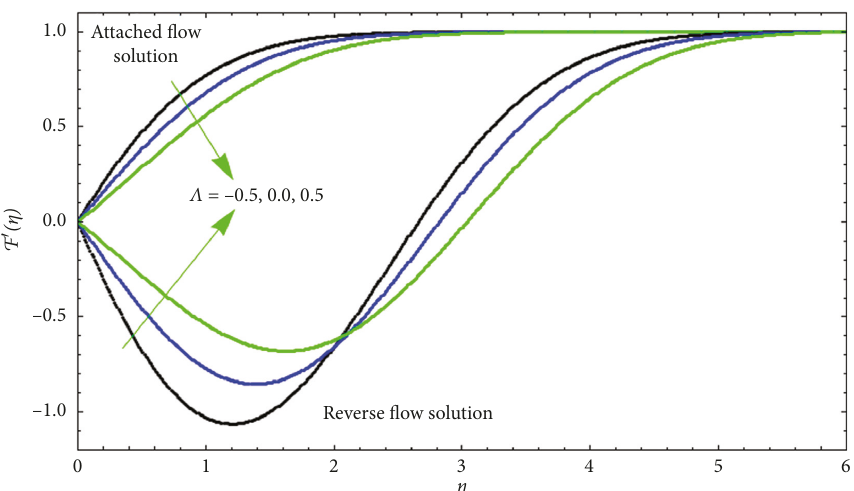
Figure 2: Dissimilarity of F ′ ( η ) being some different values of Λ parameter for two solutions AFS and RFS.